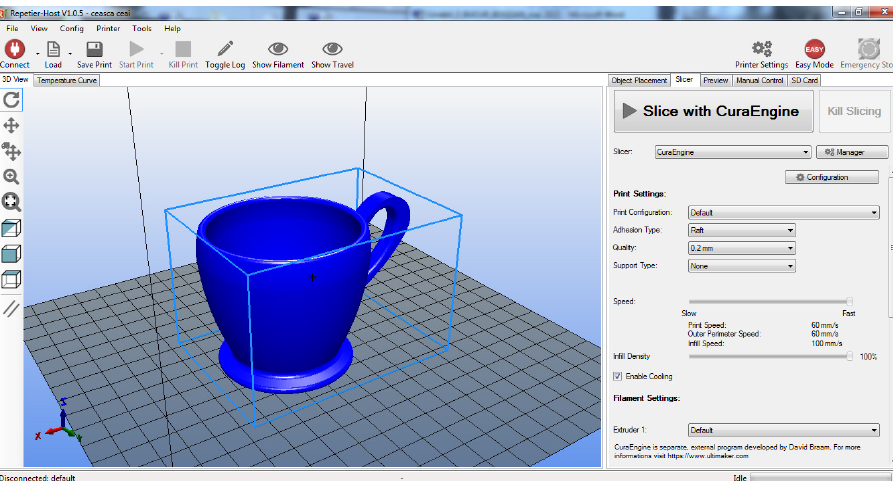
Figure 11. Cura environment interface: setting working parameters.